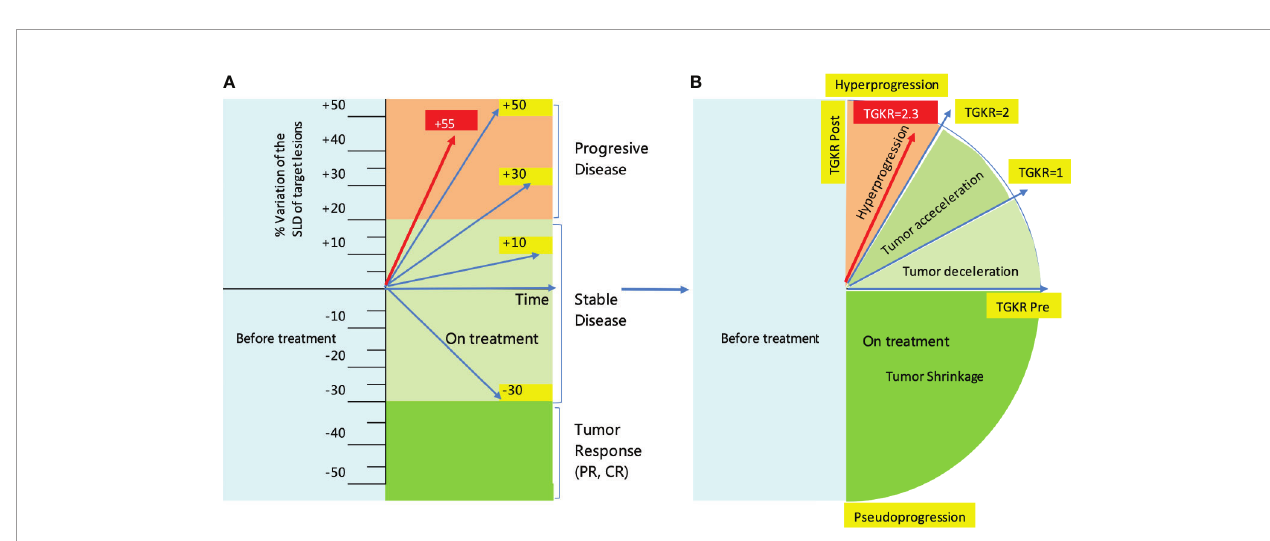
FIGURE 4 | Evaluation of HPD by the RECIST1.1 criteria and tumor growth kinetics after starting immunotherapy with pembrolizumab. (A) Evaluation of HPD by measuring the variation in the SLD of target lesions according to RECIST1.1 criteria. (B) Evaluation of HPD by measuring the TGKR. SLD, sum of the longest diameters; TGKR, tumor growth kinetics ratio; HPD, hyperprogressive disease; RECIST, response evaluation criteria in solid tumors.